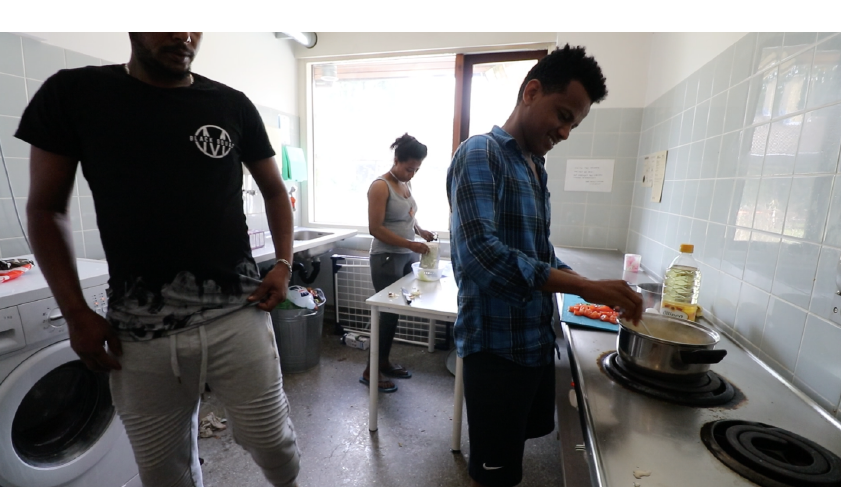
Figure 11. There would often be power outages in the kitchen, which disabled the stove. The residents would use the stove in the laundry room when the power outages occurred. April